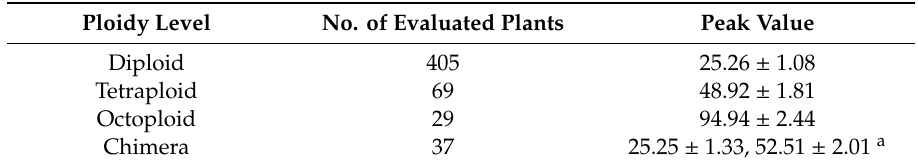
Figure 2. Analysis of ploidy level for induced plants by flow cytometry. ( A ) Diploid plantlets as control peak value = 25.26 ± 1.08; ( B ) Induced tetraploids, peak value = 48.92 ± 1.81; ( C ) Induced octoploids, peak value = 94.94 ± 2.44; ( D ),Induced chimera plantlets, peak value = 25.25 ± 1.33 and 52.51 ± 2.01, respectively. Table 1. Ploidy level analysis for induced polyploids of R. fortunei.